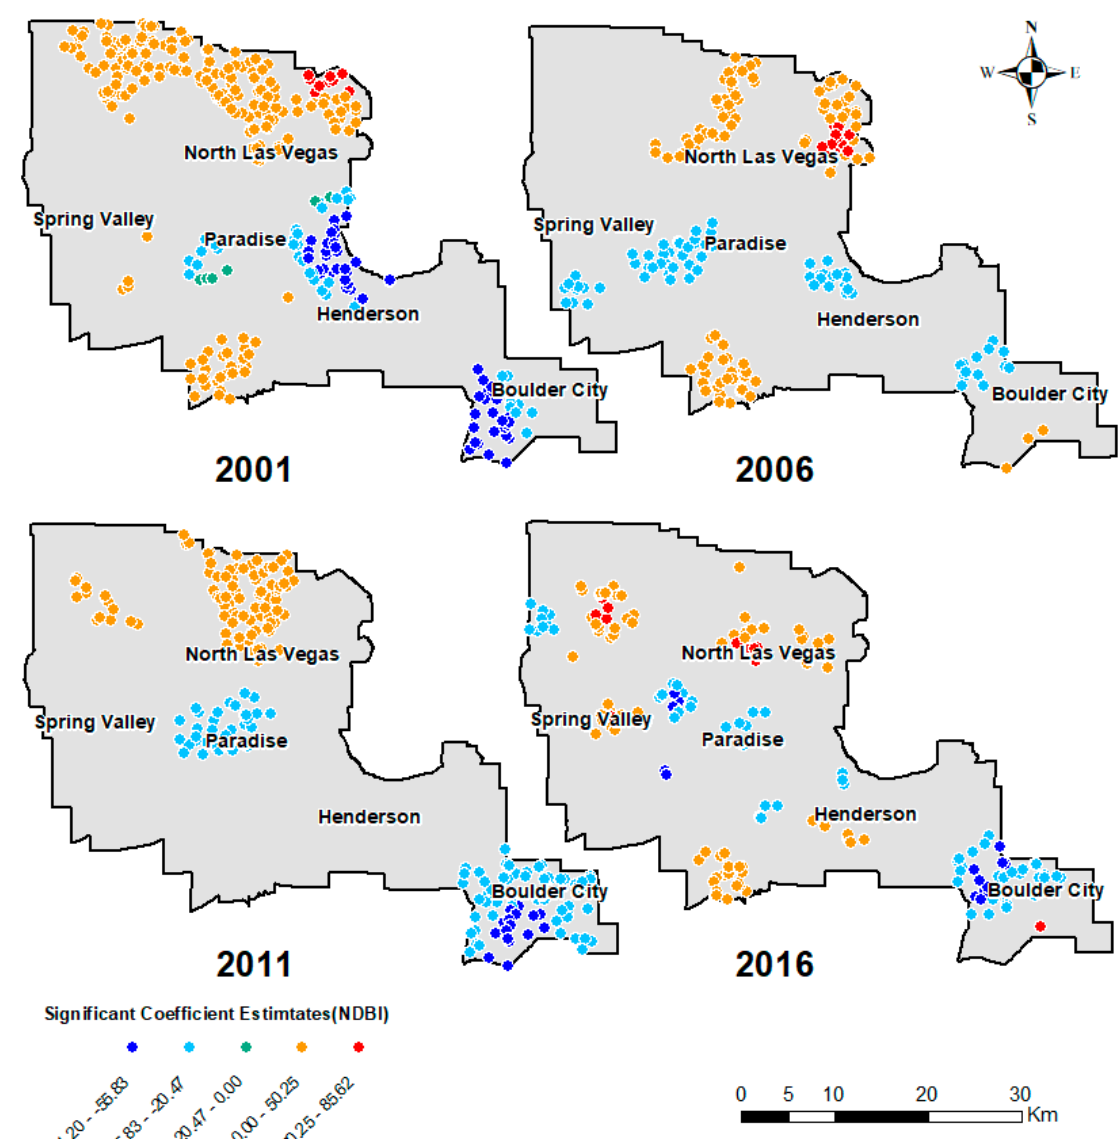
Figure 5. Spatial pattern of the normalized difference built-up index (NDBI) estimates from the GWR for four years in Las Vegas.